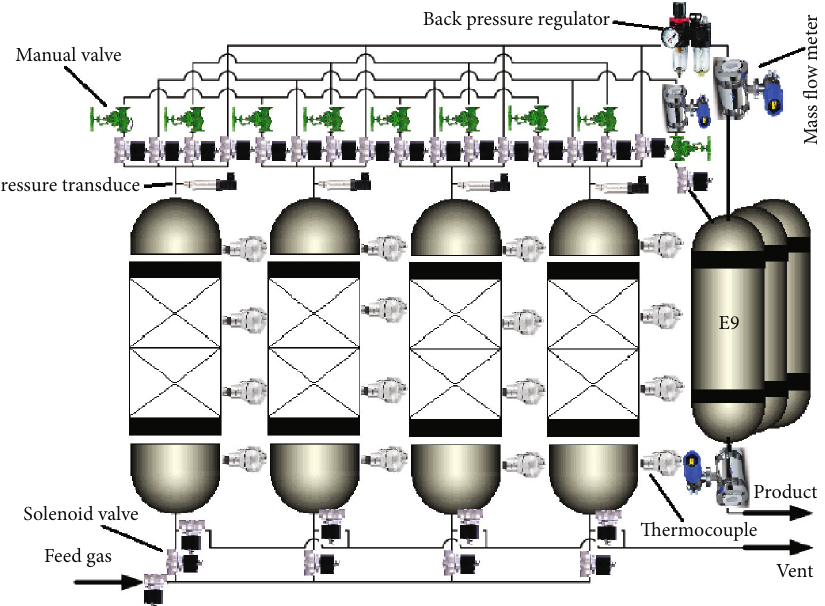
Figure 6: Schematic diagram of the PSA process using 4-beds, 9-steps.